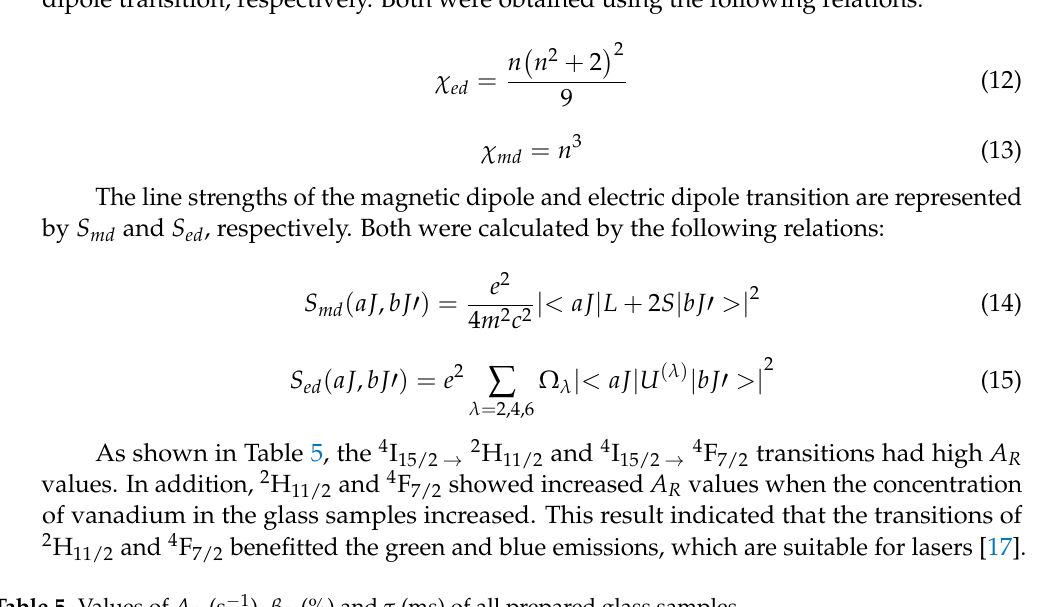
Table 5. Values of A R (s − 1 ), β R (%) and τ (ms) of all prepared glass samples.